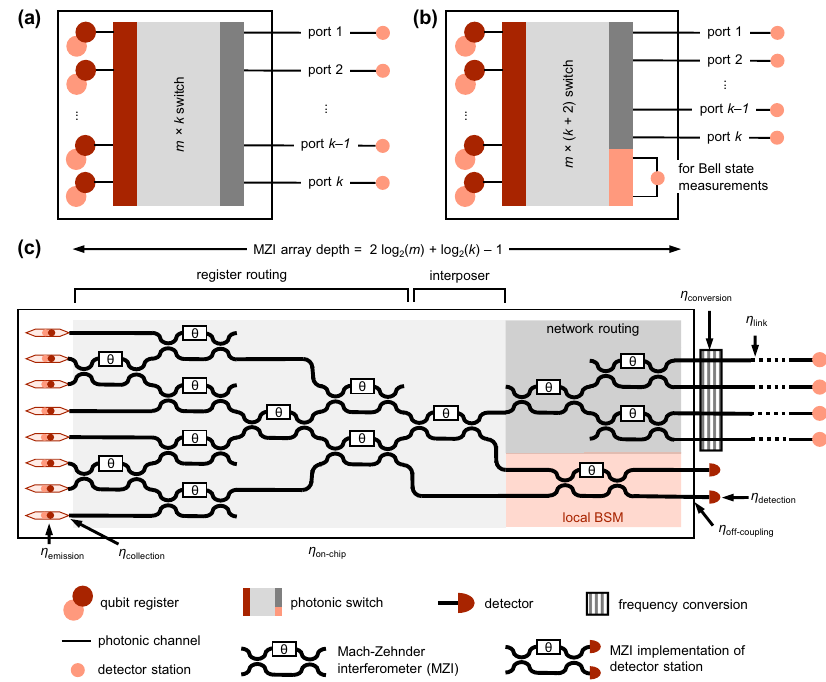
Fig. 5 Potential physical realization of k -way repeater nodes with m repeater qubit registers. The main component of our proposed router architecture is a photonic switch that provides all-to-all connectivity from ports on one side of the switch to ports on the other side. Photonic switches can take the form of a tree of Mach – Zehnder interferometers (MZIs) when the modes (Fig. 2) are temporally multiplexed or a wavelength-division multiplexer when the modes are spectrally multiplexed. a Standard repeater realization. A standard (routerless) repeater can be constructed using an m × k switch that connects all m repeater registers with the k links that go to other nodes in the network. b Router realization. A router can be constructed using an m × ( k + 2) switch. Photons emitted by the m repeater registers can travel to the k links that go to other nodes in the network, or they can be sent to a local detector station for local entanglement generation. c MZI ð m 2 k = 2 Þ , implementation of k = 4-way, m = 8-register router. A k -way, m -register router can be implemented using an MZI array of depth log 2 ð m = 2 Þ ), an interposer for routing from local to distant connections (depth 1), a network comprising a register routing layer (depth 2log 2 ð k Þ ), and a local BSM layer (depth 1). The ends of the MZI array are coupled either directly to detectors for the local routing layer (depth log 2 BSMs or a frequency conversion stage followed by fi ber links to distant detector stations for networking. All losses considered in our simulations are shown